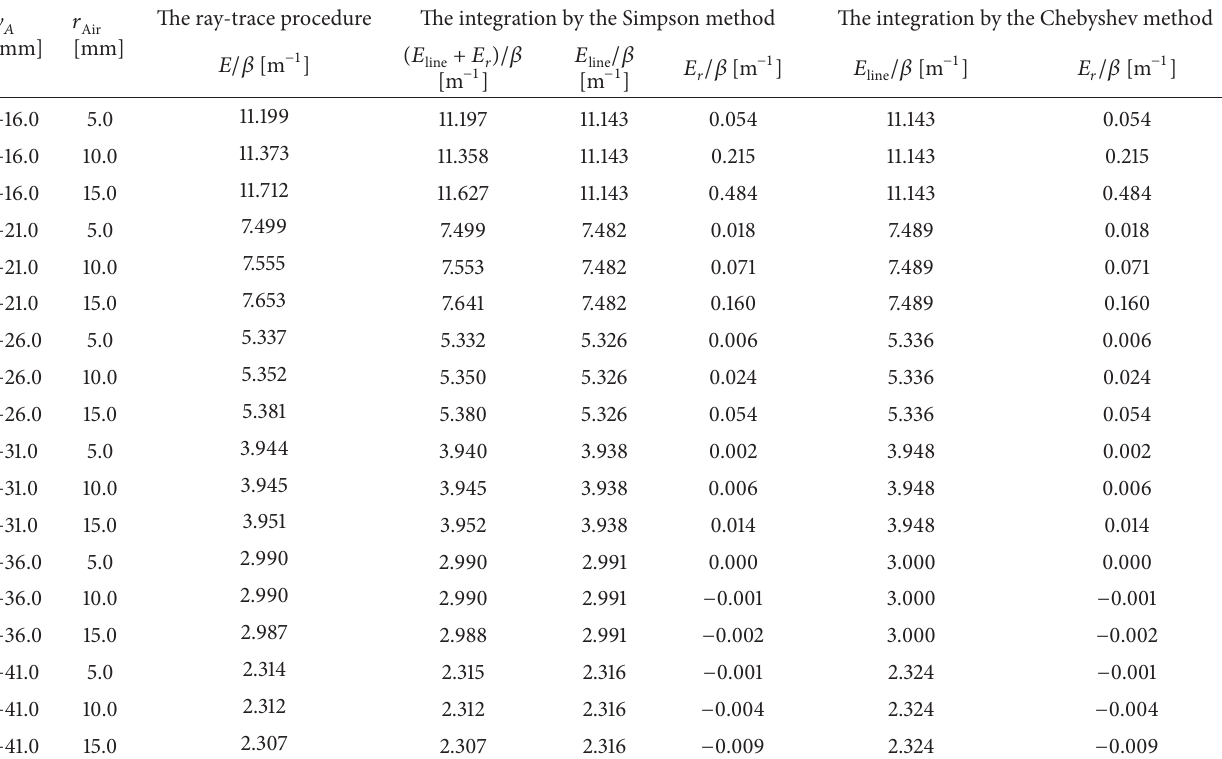
Table 2: The values of fluence rate. The transmittance of 10mm thick water layer is